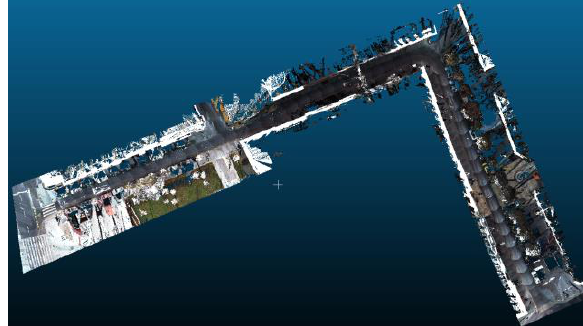
Figure 3. The MLS pilot site in the Budapest downtown (Right is the Váci street, left the Piarista street. The leftmost part is a square)